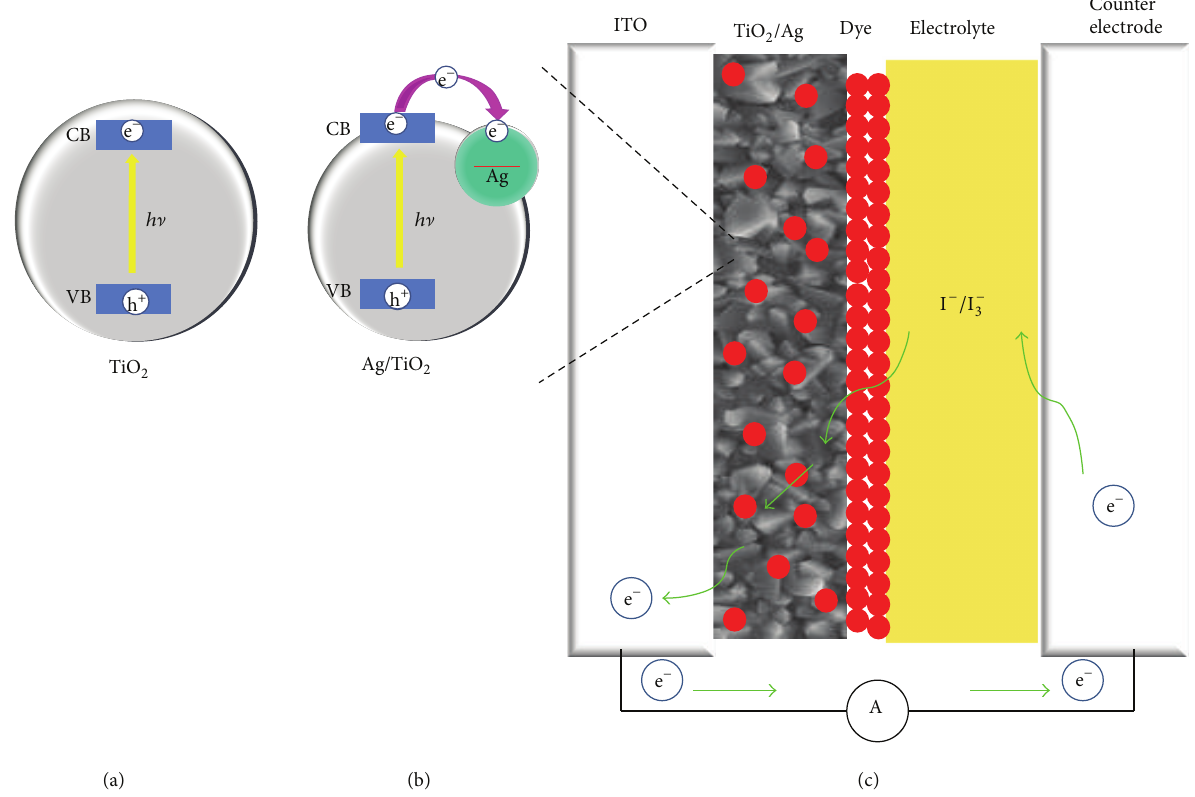
Figure 9: (a) Energy level diagram of TiO 2 , (b) transfer of charge of Ag/TiO 2 , and (c) schematic of the operation principles of the DSSC based on an Ag/TiO 2 thin film.